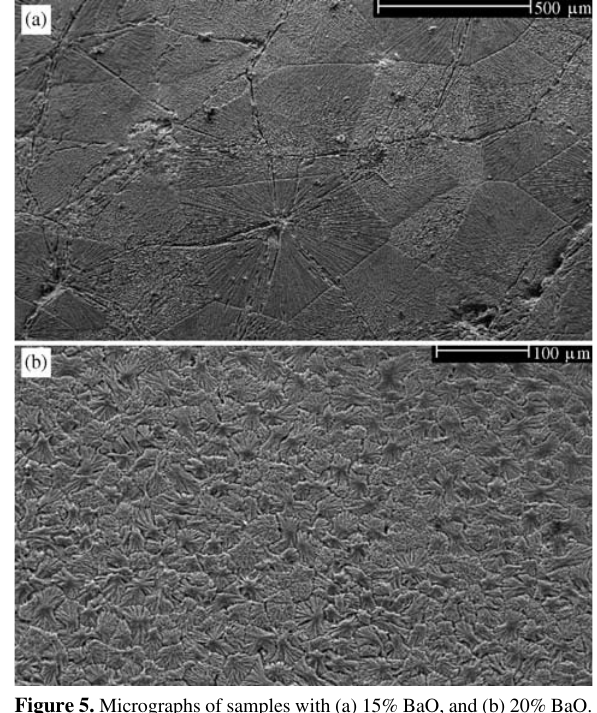
Figure 5. Micrographs of samples with (a) 15% BaO, and (b) 20% BaO.